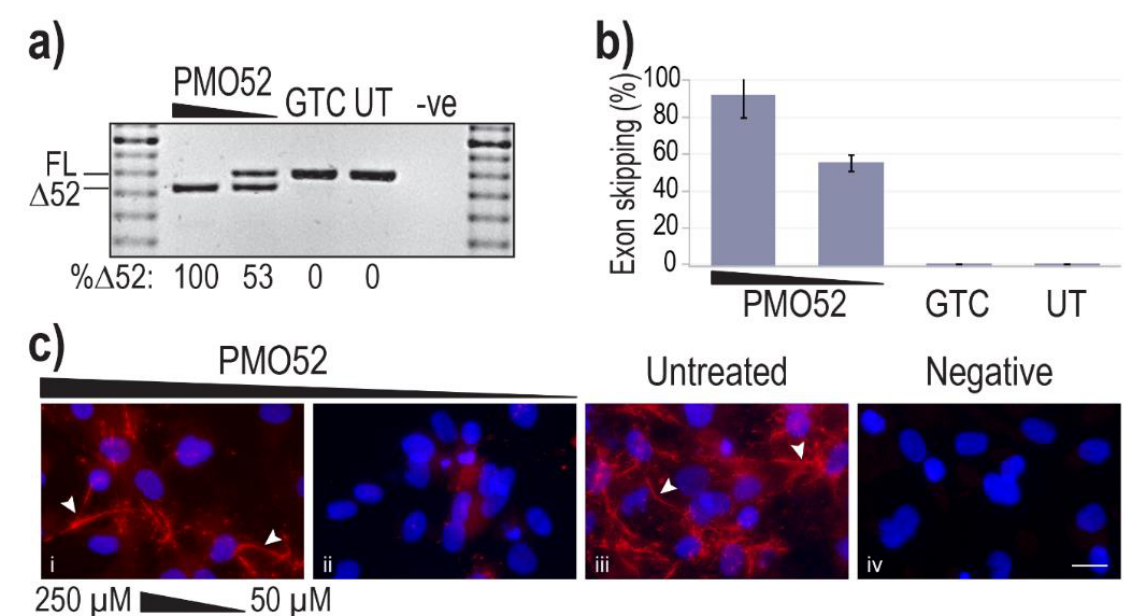
Figure 3. Efficiency and effect of PMO52. Healthy control fibroblasts were harvested for protein and RNA analysis, 72 h after nucleofection with PMO52 at concentrations of 250 µ M and 50 µ M; calculated in a 20 µ L cuvette. ( a ) Agarose gel fractionation of FBN1 exons 47 to 54 amplicons showing full-length (FL, 859 bp) and exon 52-skipped ( ∆ 52, 793 bp) transcripts. The values below the gel image indicate the percentage of Δ52 transcripts. GTC: Gene Tools control PMO, UT: Untreated control, -ve: RT-PCR negative control, 100 bp molecular marker used as a size reference. The gels were cropped for presentation. Full gel images are presented in Figure S1 ( b ) The percentage of full-length transcript relative to total FBN1 transcript across four biological replicates (means plus error bars. Error bars = standard deviation, n = 4). ( c ) Fibrillin-1 protein analysed via immunofluorescent staining. Merged fluorescence images of Hoechst staining of the nucleus (blue) and fibrillin-1 (red) with ‘healthy’ fibre-like morphology of fibrillin-1 indicated by white arrowheads. Negative: no primary antibody added, to control for non-specific binding of the secondary antibody. Untreated: no PMO added. Scale bar = 20 µm. The images were cropped for presentation. Full images are presented in Figure S3.